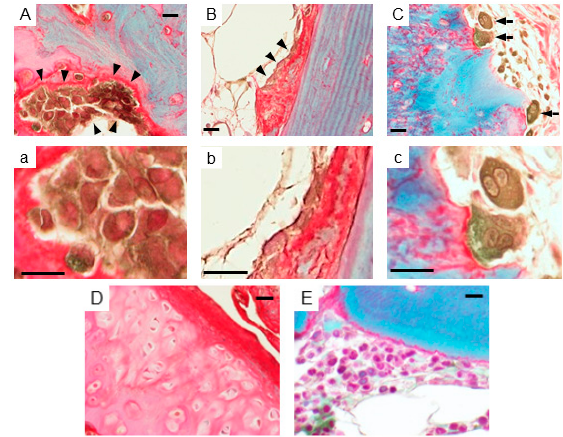
Figure 1. Immunohistochemistry of AhR in bone tissues. ( A , B ). AhR immunoreactivity ( brown ) was detected in osteoblasts ( arrowheads ); ( a ) and ( b ) are high magnifications of ( A ) and ( B ), respectively. AhR was detected at high levels in the cytoplasm ( brown ) and low levels in nuclei ( reddish-brown ). ( C ). AhR immunoreactivity ( brown ) was detected in osteoclasts ( arrows ); ( c ) is a high magnification of ( C ). Relatively high levels of AhR immunoreactivity were detected in both cytoplasm and nucleus. No AhR immunoreactivity was detected in ( D ) chondrocytes and ( E ) bone stromal cells. Collagen protein was stained red. Non-collagen proteins including calcified bone matrix were stained bluish-green. Both cytoplasm and nuclei were stained red using the K61 Collagen Stain Kit (Collagen Research Center, Kiyose, Tokyo, Japan). Scale bar, 5 µ m. AhR, aryl hydrocarbon receptor.